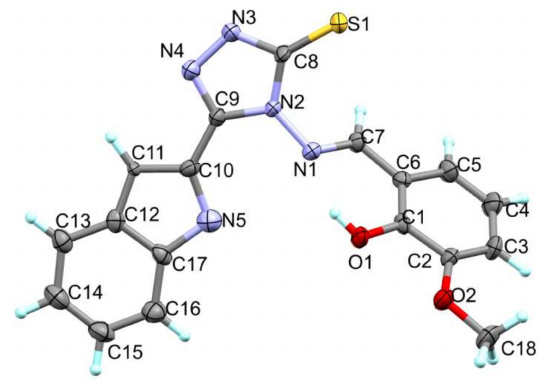
Figure 3. Structure and atom numbering of 6